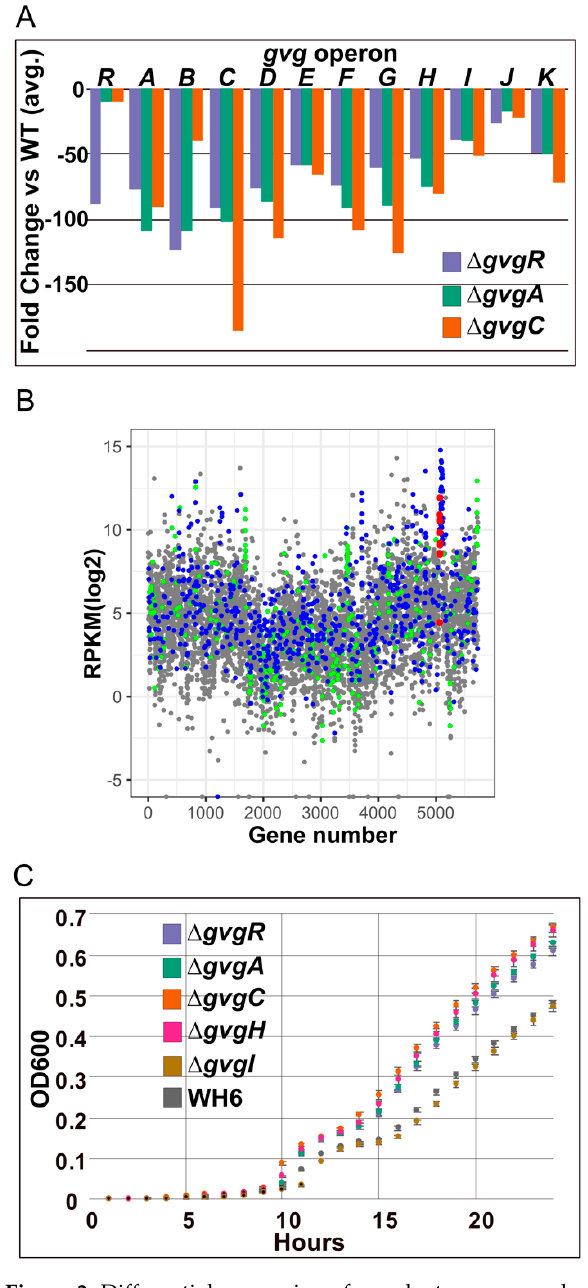
Figure 3. Differential expression of gvg cluster genes and growth of gvg cluster mutants. ( A ) Downregulation of all genes in the gvg cluster in Δ gvg R , A , and C strains. ( B ) Reads per kilobase of transcript, per million mapped reads (RPKM) for each gene plotted across the WH6 genome. Color coding indicates predicted gene function, including transcription and translation (blue); energy production (green), and gvg production (red). ( C ) Growth of gvg cluster mutants. Points represent a single experiment with 8 replicates. Error bars represent standard error. Two additional experiments were conducted with similar results.